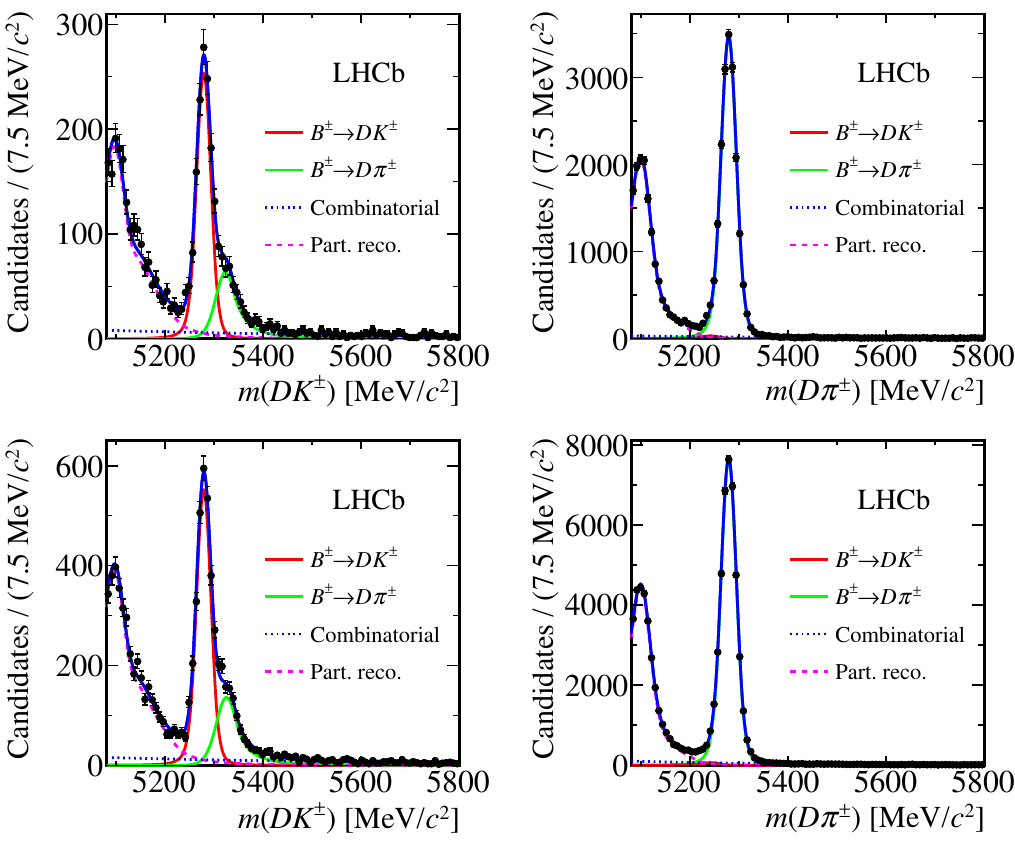
Figure 3 . Invariant-mass distributions of (left) B (cid:6) ! DK (cid:6) and (right) B (cid:6) ! D(cid:25) (cid:6) candidates, with D ! K 0 (cid:25) + (cid:25) (cid:0) , shown separately for the (top) long and (bottom) downstream K 0 S Fit results, including the signal component and background components due to misidenti(cid:12)ed com- panions, partially reconstructed decays and combinatorial background, are also shown.